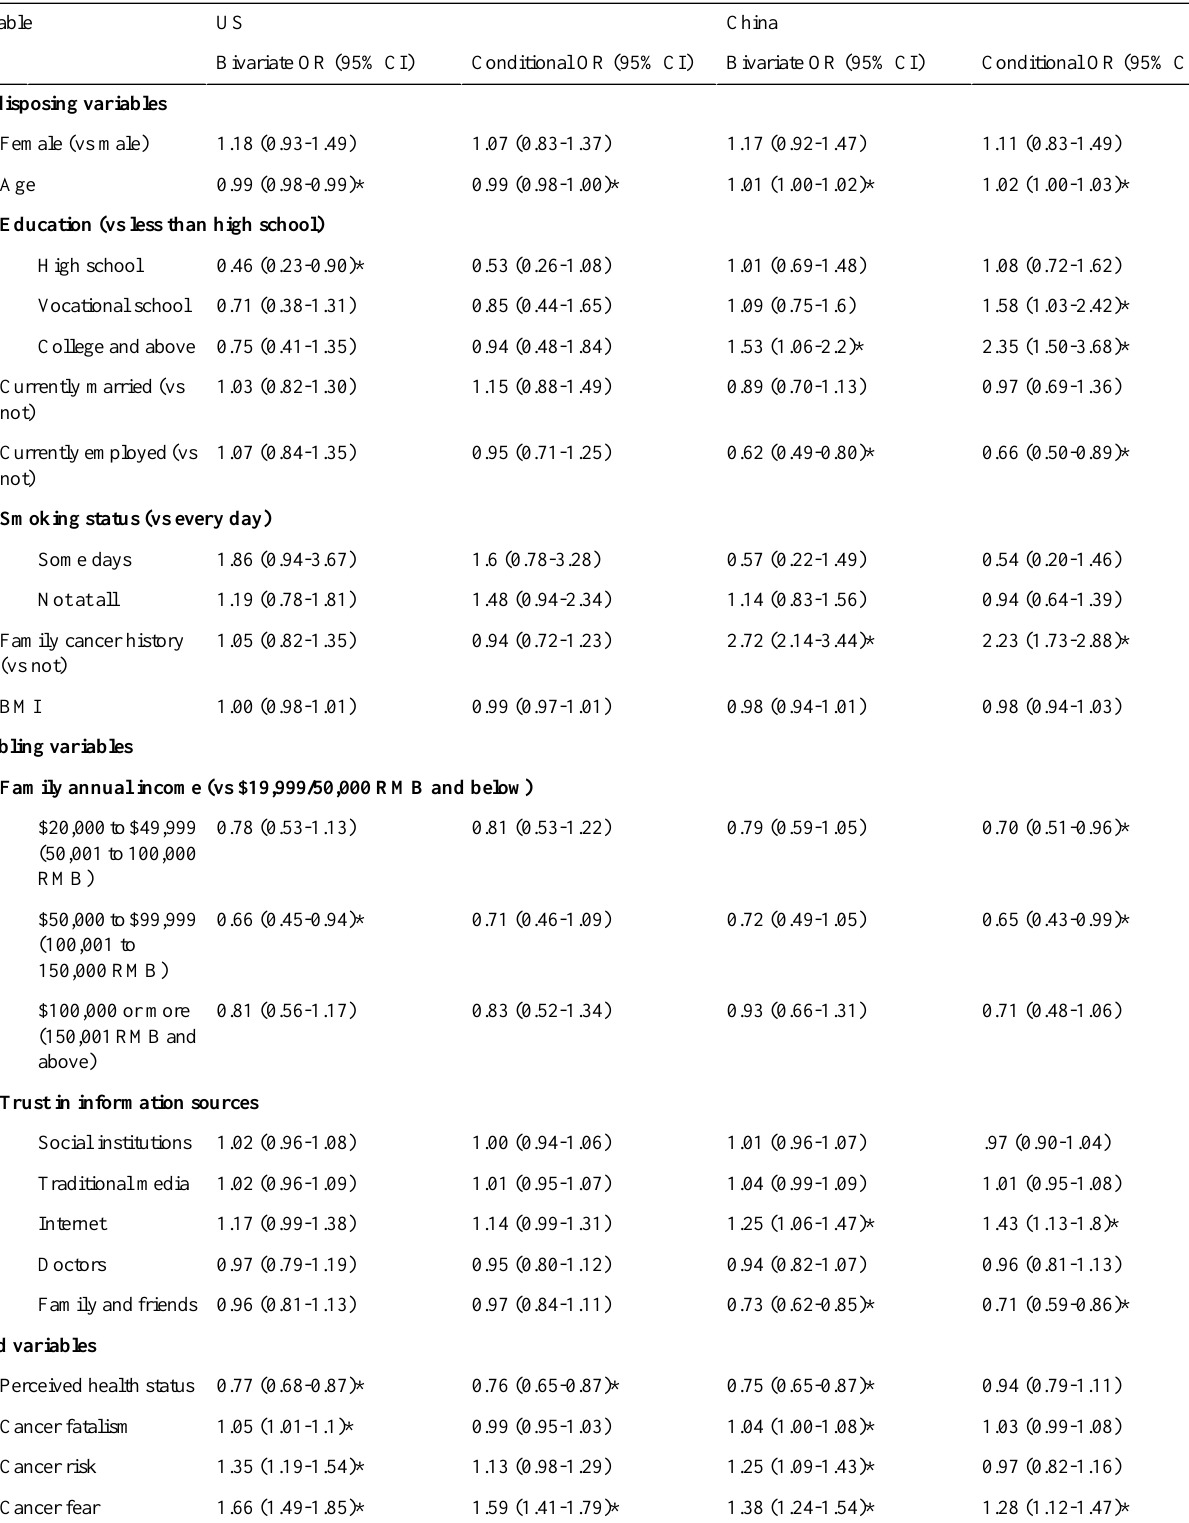
Table 3. Bivariate and conditional odds ratios (ORs) for logistic regression of predisposing, enabling, and need variables of internet cancer information seeking.